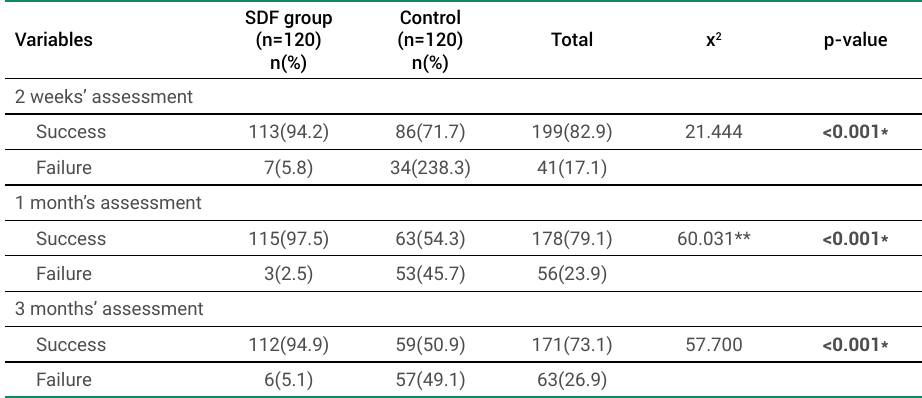
Table 2. Distribution of Arrested Caries /Restorative Success at different intervals of